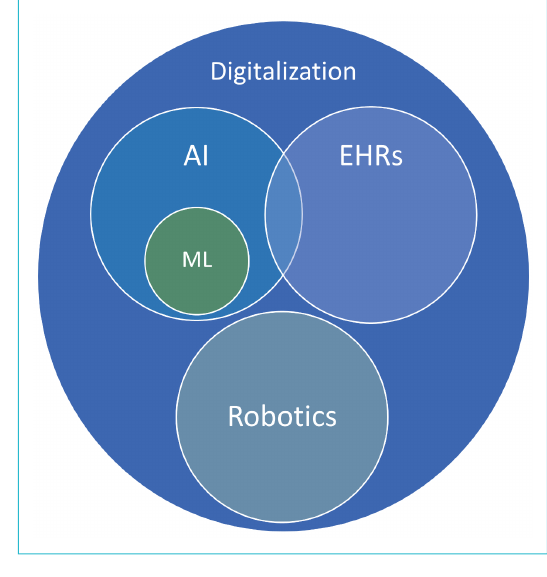
Figure 2: A rough conceptual attempt at differentiating between the spaces of digitisation, AI and